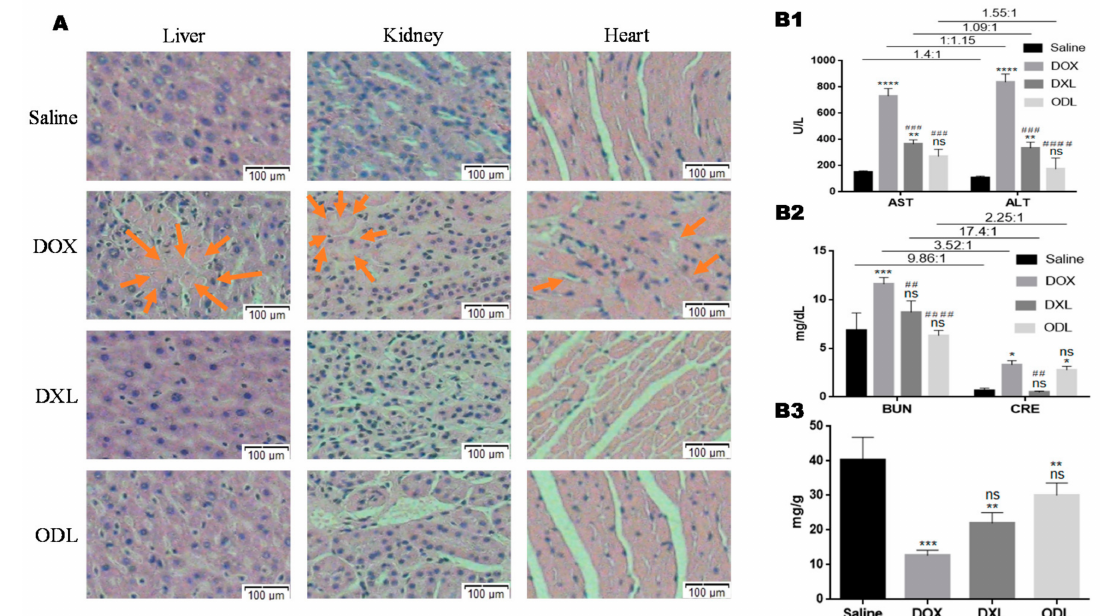
Figure 9. Combined effect of OA and DOX on vital organs i.e., liver, kidney and heart of female Kunming mice ( n = 3) ( A ) Histopathological examination (H & E staining, magnification: 10 × ), ( B ) Laboratory findings (biomarkers): ( B1 ) Liver function test (AST, ALT), ( B2 ), Kidney function test (BUN, CRE), ( B3 ) Cardiac function test (GSH-Px). The results compared with control (saline) were represented as: p < 0.05 (*), p < 0.01 (**), p <0.001 (***), p <0.0001 (****), and the results compared with DOX were represented as: p < 0.05 (#), p < 0.01 (##), p < 0.001 (###), p < 0.0001